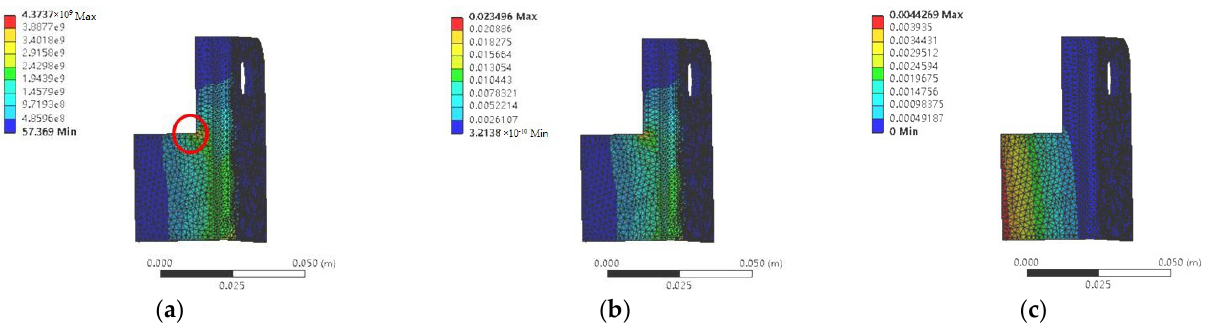
Figure 12. Stress, strain, deformation cloud map. ( a ) Stress analysis cloud diagram; ( b ) strain analysis cloud diagram; ( c ) total deformation analysis cloud diagram.